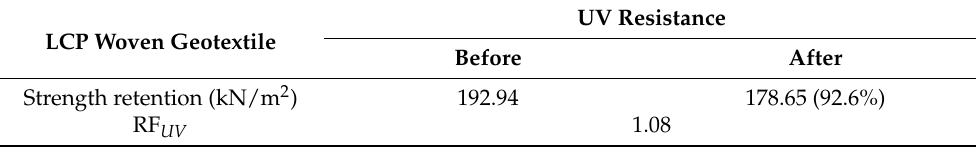
Table 5. Strength retention and reduction factor for UV resistance of LCP woven geotextile.